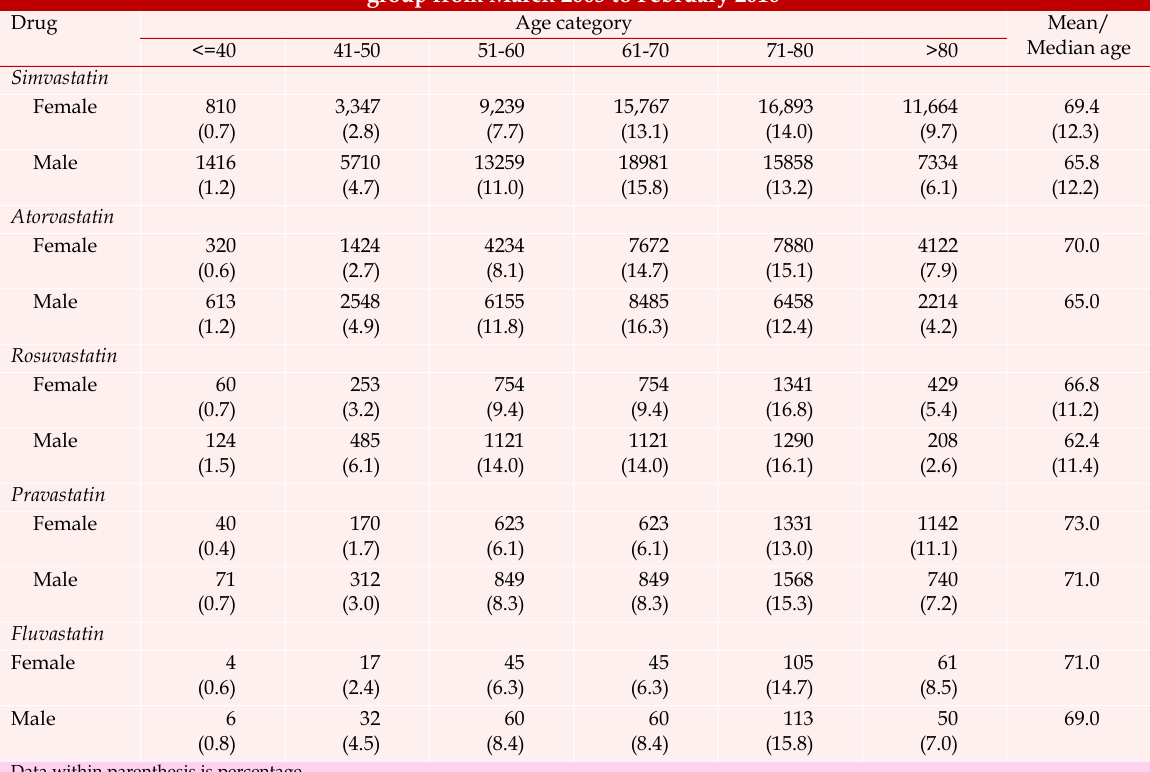
Proportion and mean/median age of female and male patients prescribed five statins in different age group from March 2005 to February